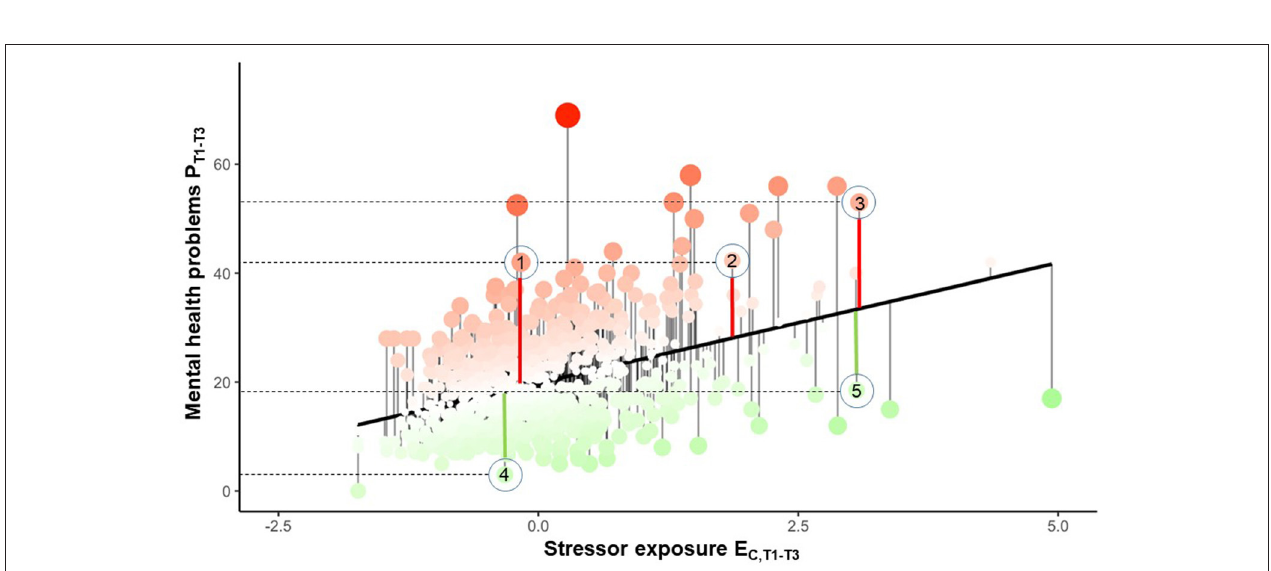
FIGURE 4 | Individual mental health reactivity to stressor exposure (“stressor reactivity”). The regression line shows the normative linear positive relationship between combined exposure to LEs and DHs stressors (E C,T1 − T3 ) and mental health problems (P T1 − T3 ) in subjects providing partial data during the first 9 months of the study (monitoring time points T1–T3). The residuals onto the regression line are subjects’ deviations from the normative E C -P relationship. A strong positive deviation reflects high susceptibility of the subject’s mental health to the effects of DHs and LEs (high stressor reactivity, SR) during the chosen time window; a strong negative deviation reflects abnormally low susceptibility (low SR). 1–5 denote arbitrarily chosen